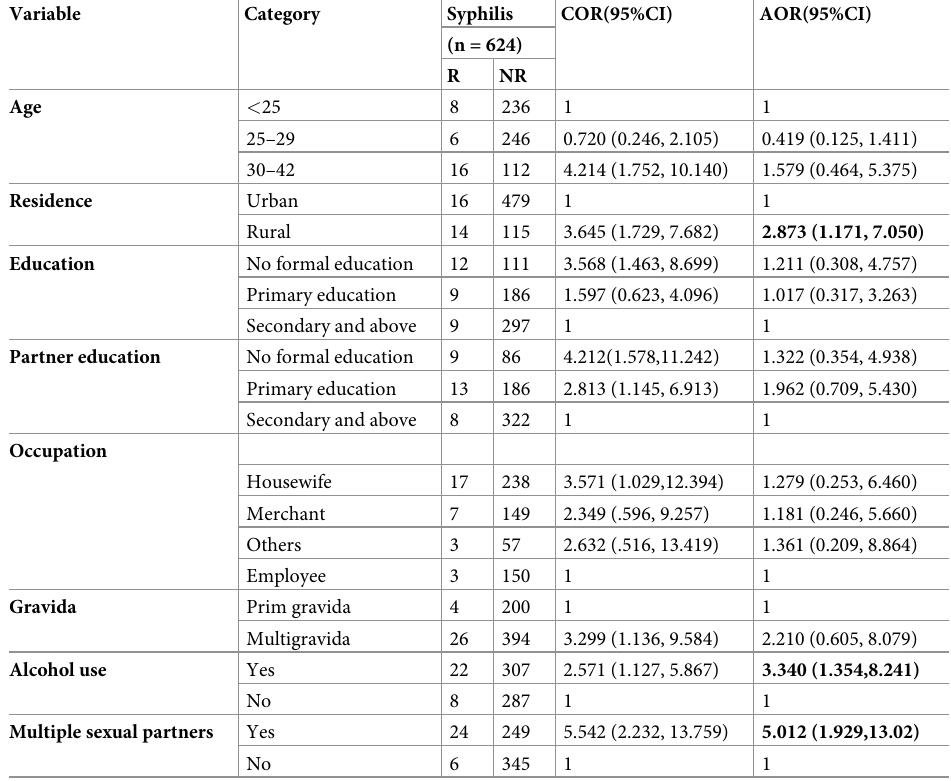
Table 4. Factors associated with seroprevalence of syphilis among ANC attendees in Jinka town public health facilities, southern Ethiopia, bivariable and multivariable analysis, 2020.